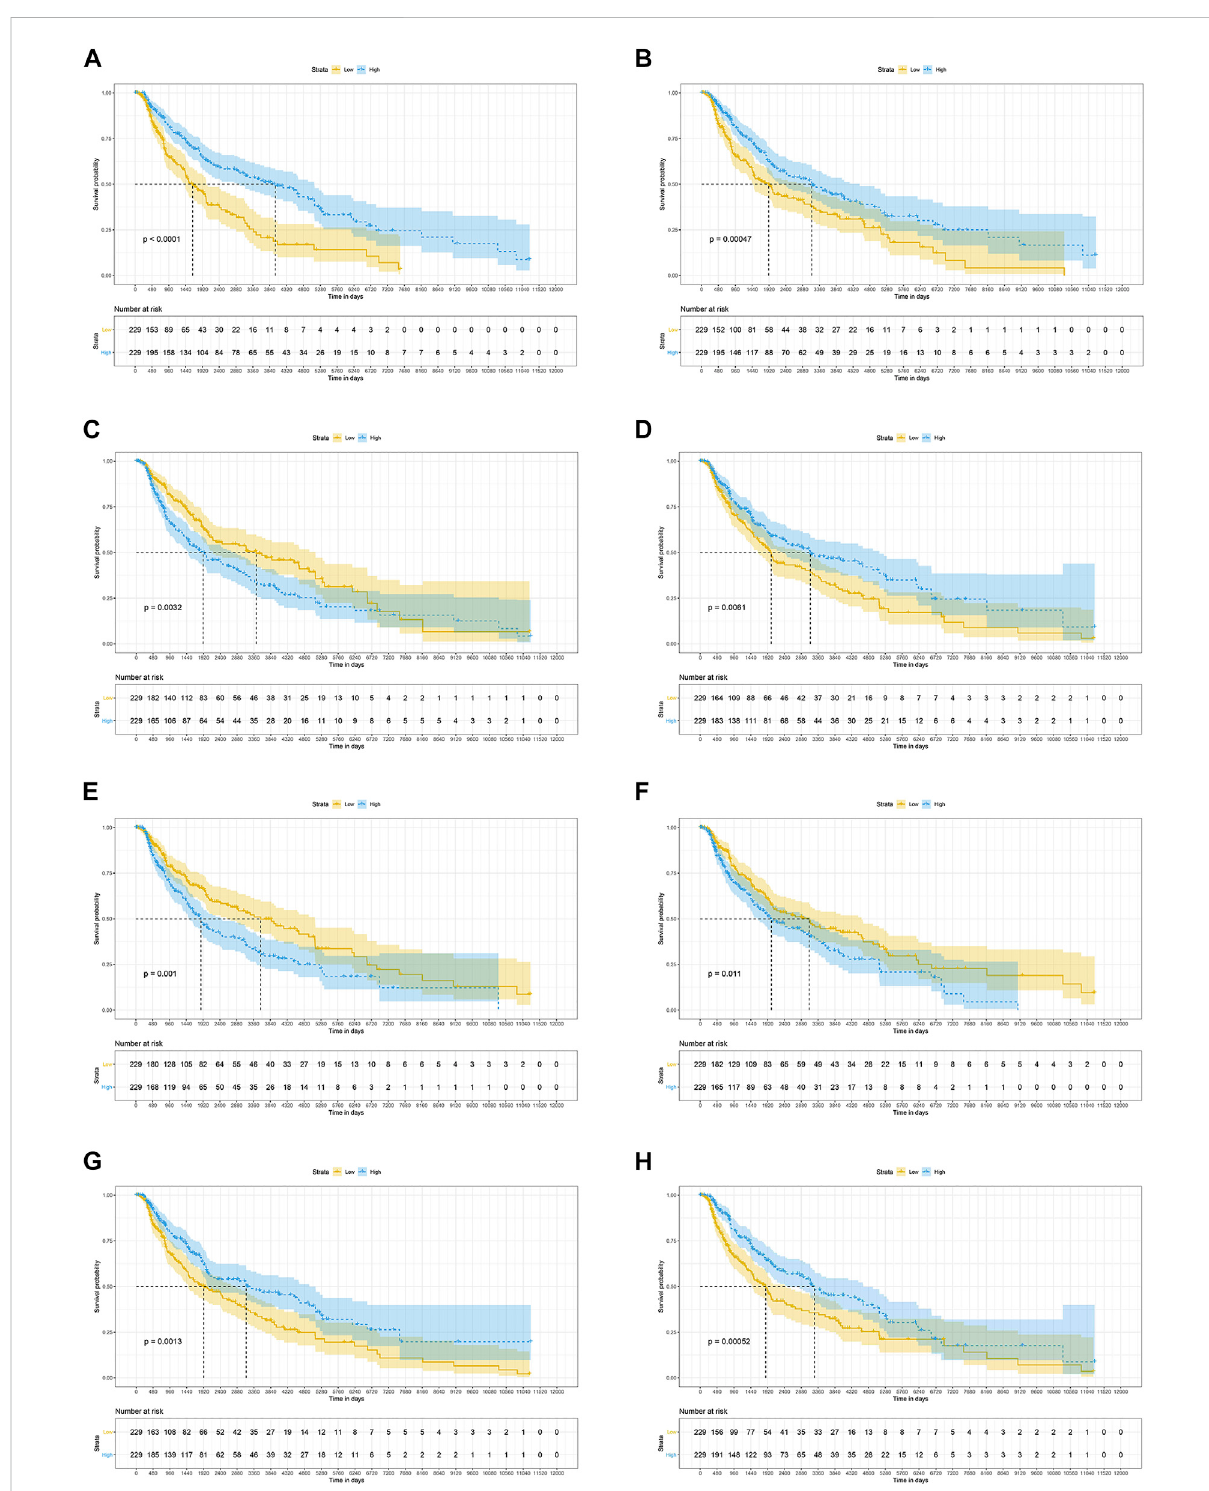
FIGURE 3 The prognostic signi fi cance of common targets for theOS ofSKCM patients (A – H) Kaplan-Meier survival curves for all SKCMpatients based on DPYD (A) , DPYS (B) , GPI (C) , LYN (D) , MMP2 (E) , PCSK9 (F) PRKCQ (G) , and TLR1 (H) expression ( n = 458). OS, overall survival; SKCM, skin cutaneous